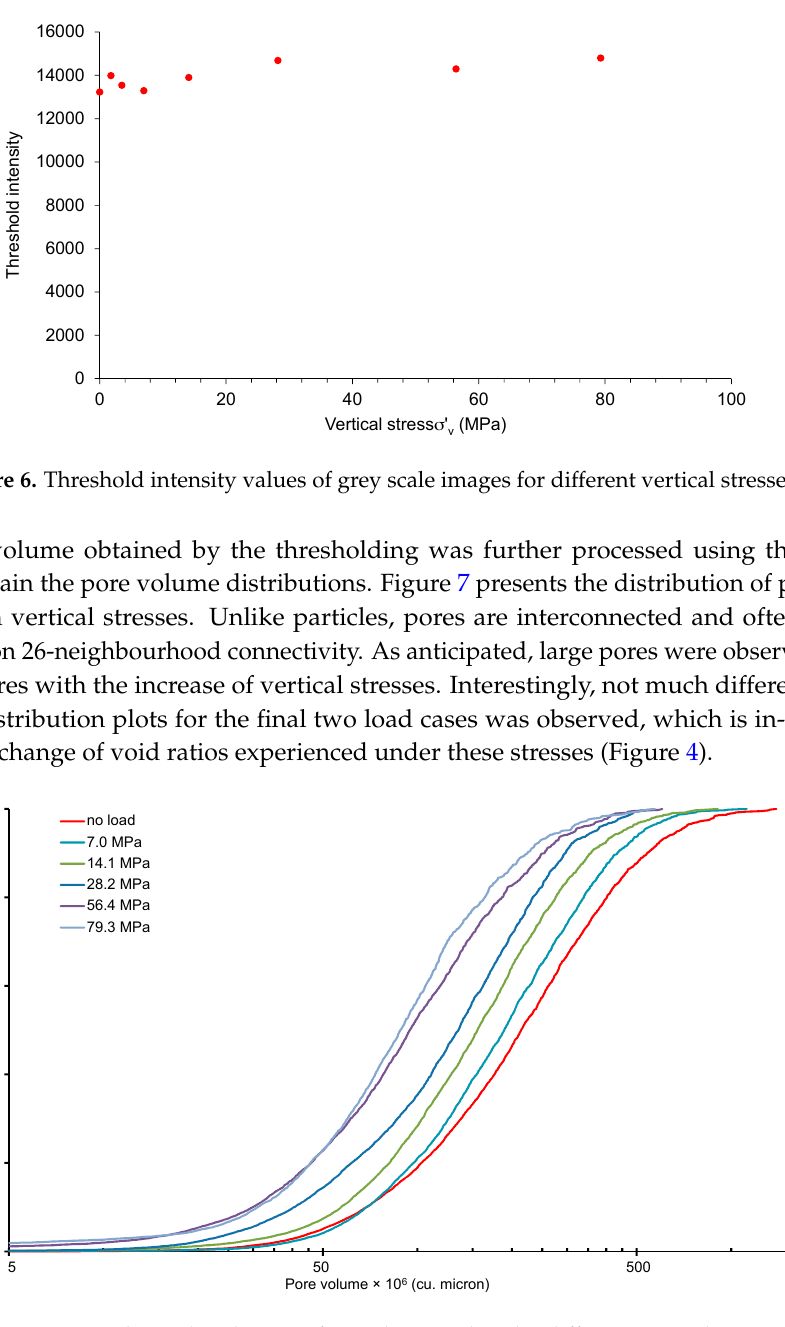
Figure 7. Pore volume distribution of samples tested under different vertical stresses.